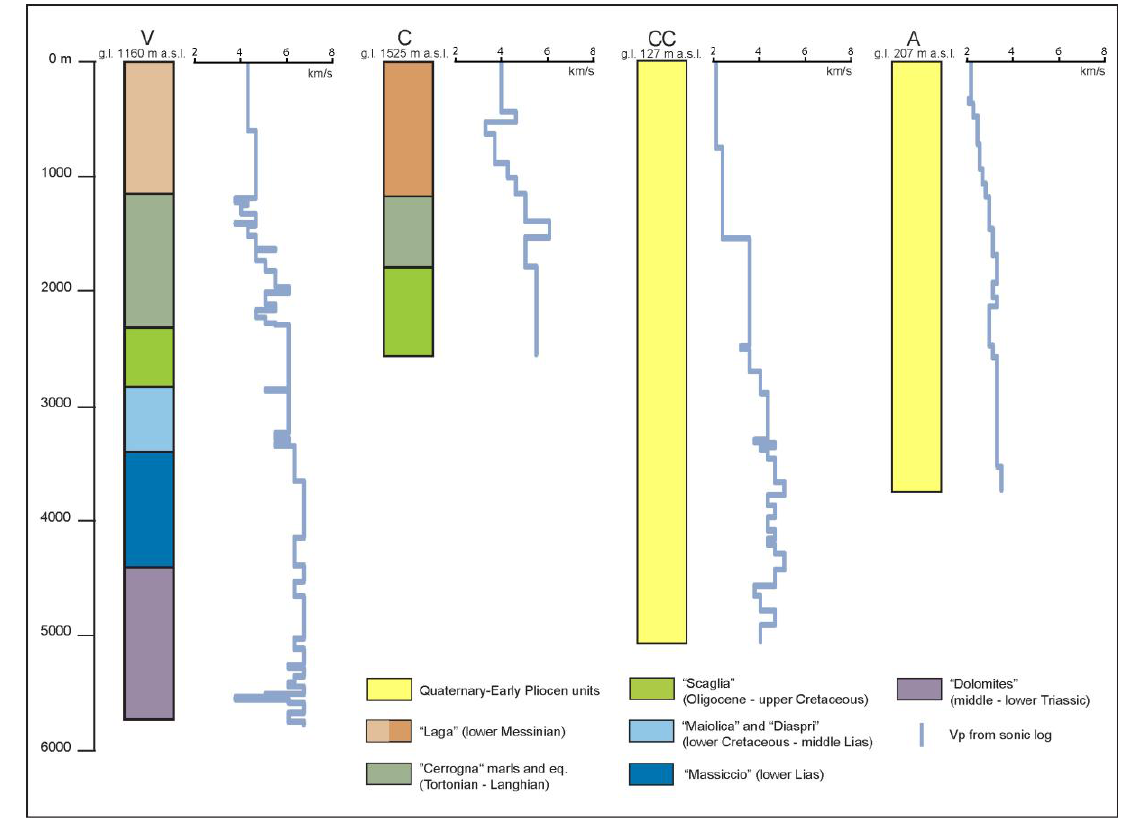
Figure 3. Stratigraphic sequence and P-wave velocity (Vp) at depth along V, C, CC, and A wells (see Figure 1 for loca- tion) as inferred from sonic